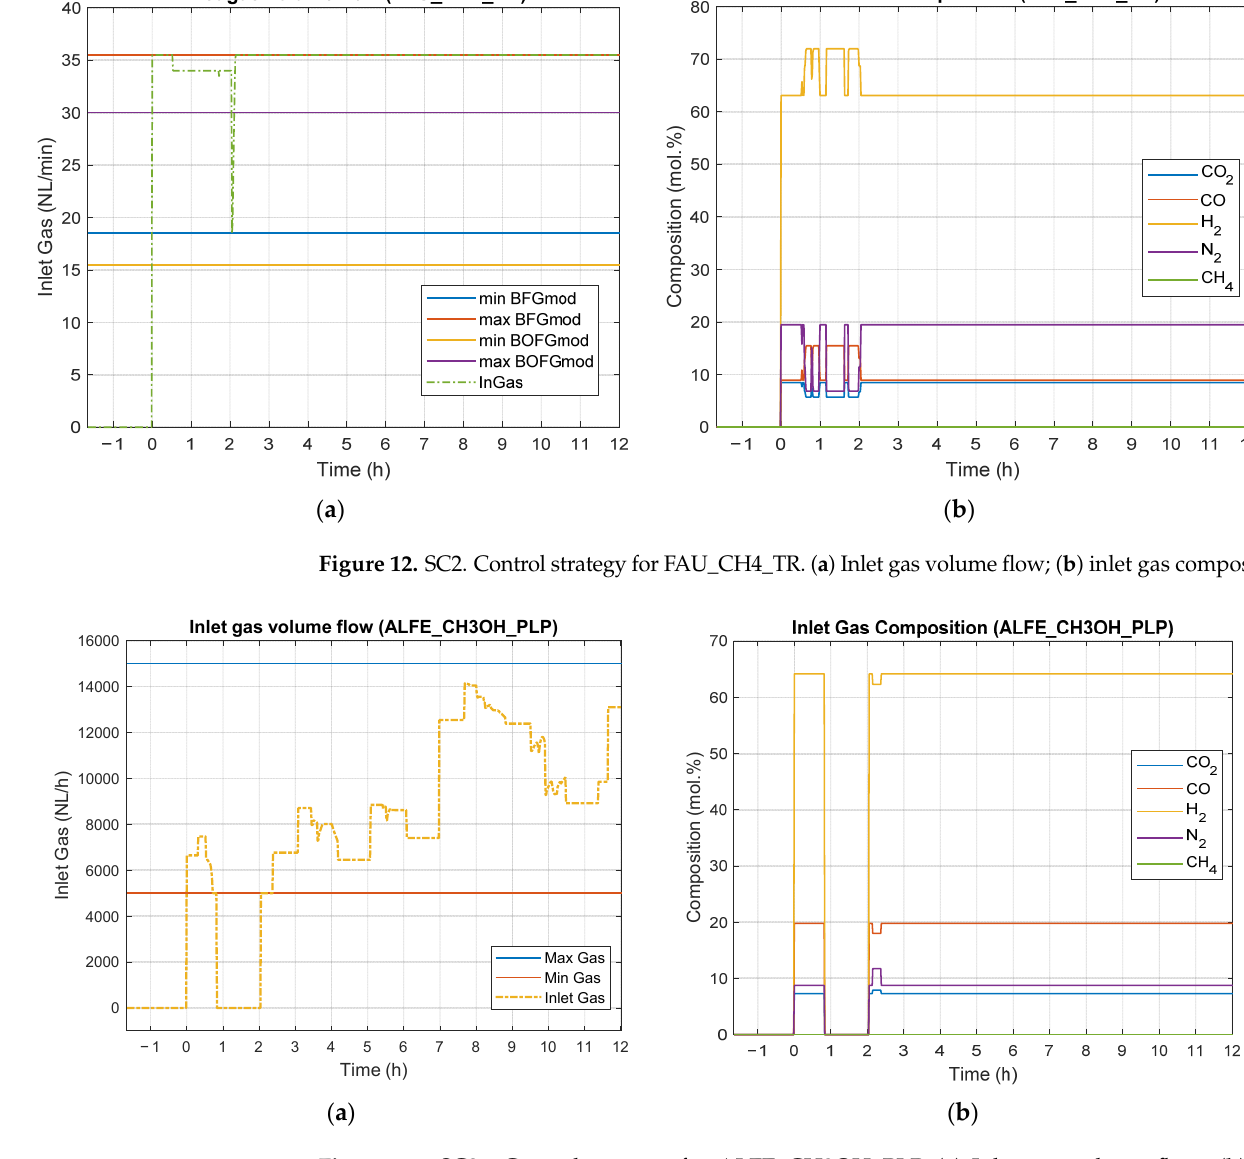
Figure 13. SC2. Control strategy for ALFE_CH3OH_PLP. ( a ) Inlet gas volume flow; ( b ) inlet gas composition.